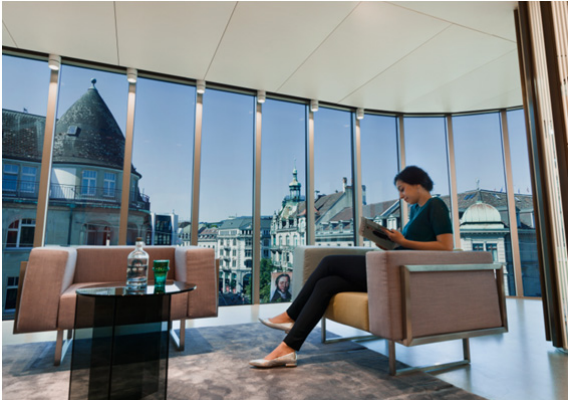
Fig. 9 The interior of Modissa fashion store. EC glass is used to provide customers a pleasant indoor feeling and an unobstructed view of the Bahnofstrasse in Zurich. © Vetrotech Saint-Gobain.